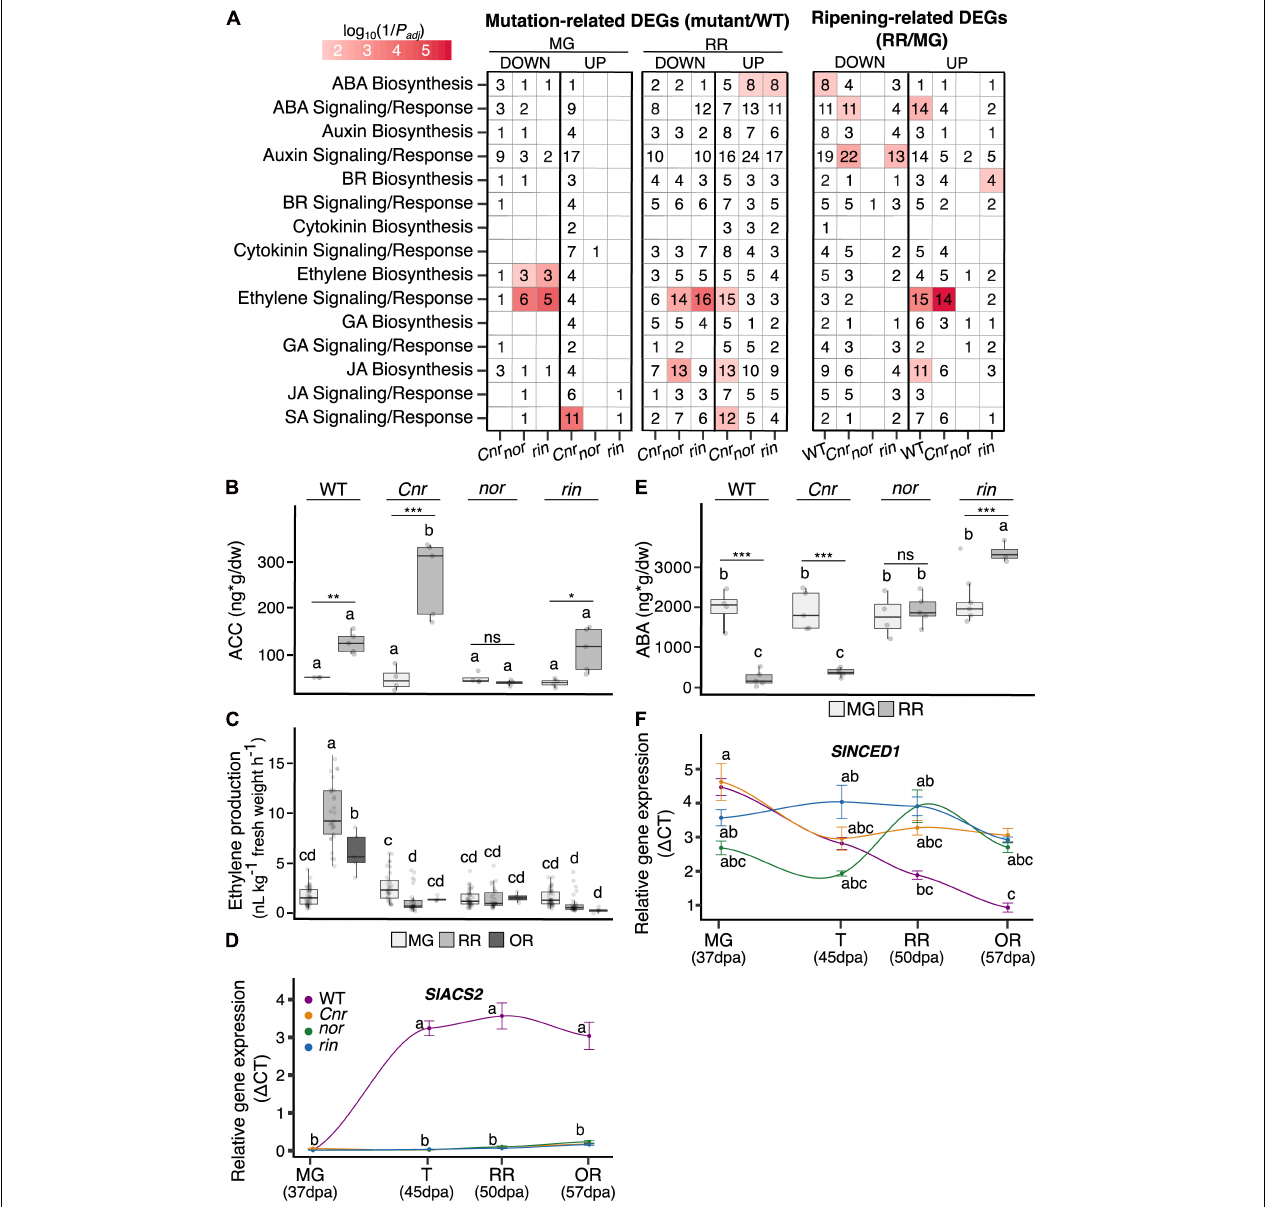
FIGURE 3 | Plant hormone networks altered in the single ripening mutants Cnr , nor , and rin . (A) Functional enrichments in hormone functions among differentially expressed genes (DEGs; P adj ≤ 0.05) in two comparisons: mutation-related DEGs obtained when comparing each mutant to the wild type (WT) at the mature green (MG) and red ripe (RR) stages, and ripening-related DEGs when the RR stage was compared against MG for each genotype. Each comparison is separated into significant down- and up-regulated DEGs. The heat map colors indicate the significance of the functional enrichment using a log 10 (1/ P adj ) scale. Numbers in each tile indicate the number of DEGs within each category. Only significant ( P adj ≤ 0.05) functional enrichments are shown. Hormone measurements of the (B) ethylene precursor 1-aminocyclopropane-1-carboxylate (ACC) ( n = 4–6), (C) ethylene ( n = 5–45), and (E) abscisic acid (ABA) ( n = 4–6) for WT, Cnr , nor , and rin fruit at the MG, RR, and/or overripe (OR) stages. Relative gene expression by RT-qPCR of key hormone biosynthesis genes of (D) ethylene and (F) ABA across ( n = 6) across four ripening stages MG, turning (T), RR, and OR for each genotype. Error bars represent standard error between biological replicates of each sample. Letters in (B–F) indicate significant differences among genotypes and ripening stages calculated by ANOVA and Tukey HSD ( P ≤ 0.05). Asterisks in (B,C,E) denote significant differences (* P ≤ 0.05, ** P ≤ 0.01, *** P ≤ 0.001) between two ripening stages within a single genotype calculated by Student’s t-